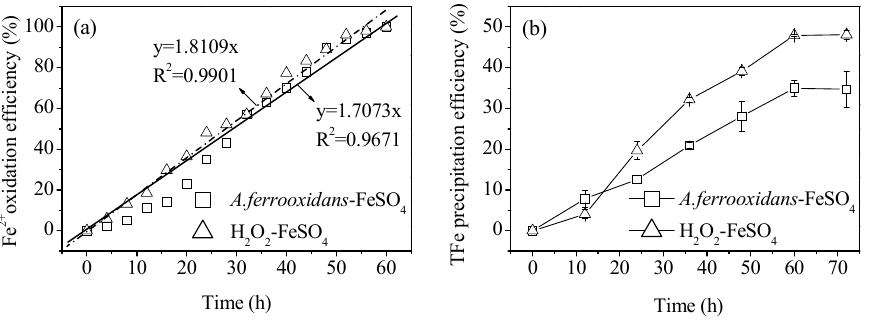
Figure 1. Comparison of ( a ) Fe 2+ oxidation efficiency and ( b ) total Fe precipitation efficiency in the biological and chemical mineralization systems at 28 ◦ C and 180 rpm for 72 h. Experimental conditions: initial pH = 3.0; FeSO 4 · 7H 2 O dosage 11.12 g; A. ferrooxidans density 6.0 × 10 6 cell · mL − 1 ; H 2 O 2 volume 6 mL.